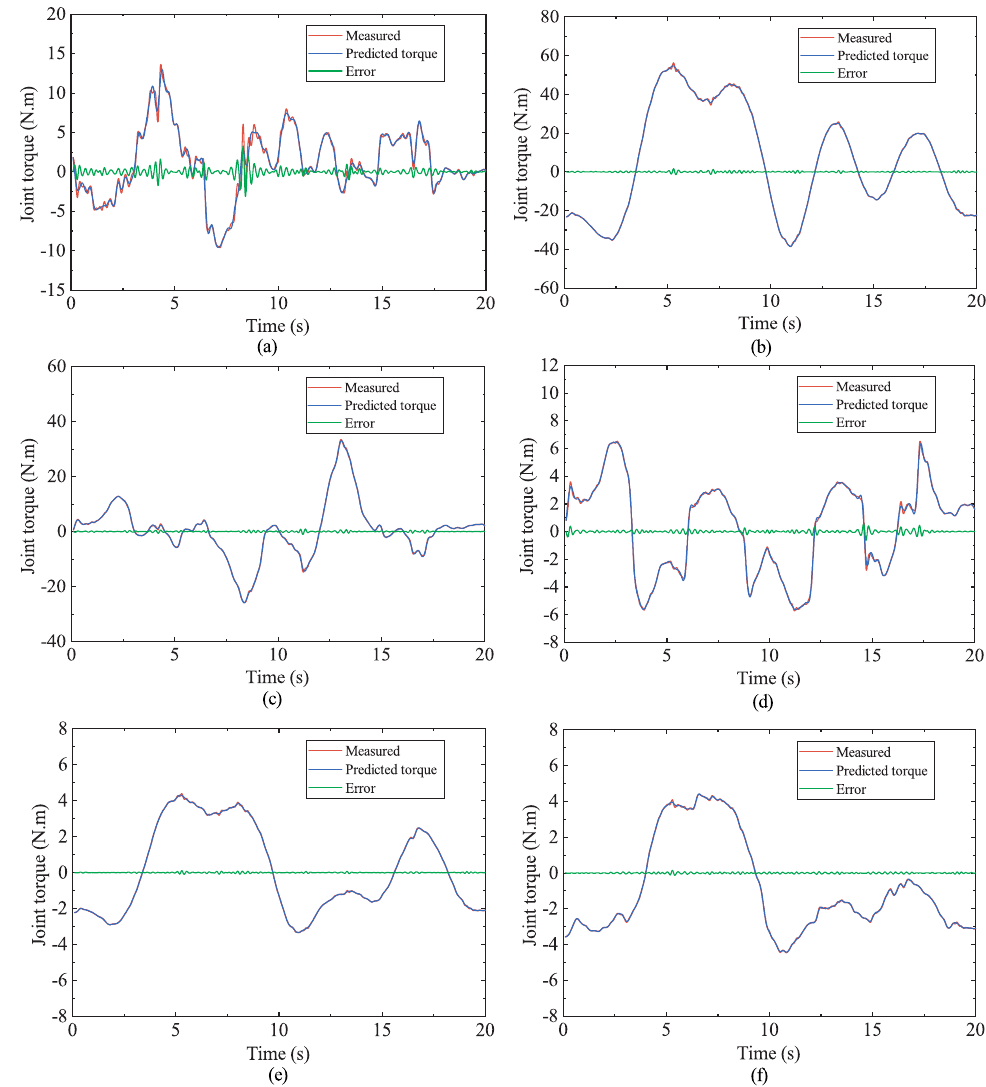
Figure 8. Comparison of predicted torque and measured torque of collaborative robot. ( a ) Predicted torque of joint 1 by identification. ( b ) Predicted torque of joint 2 by identification. ( c ) Predicted torque of joint 3 by identification. ( d ) Predicted torque of joint 4 by identification. ( e ) Predicted torque of joint 5 by identification. ( f ) Predicted torque of joint 6 by